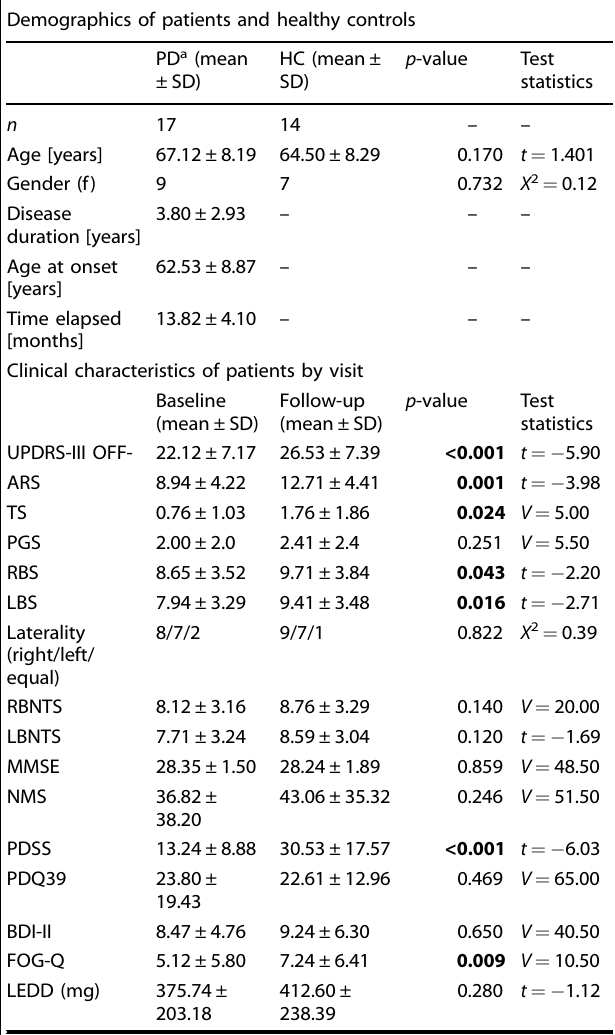
Table 1. Demographic, clinical, and behavioral